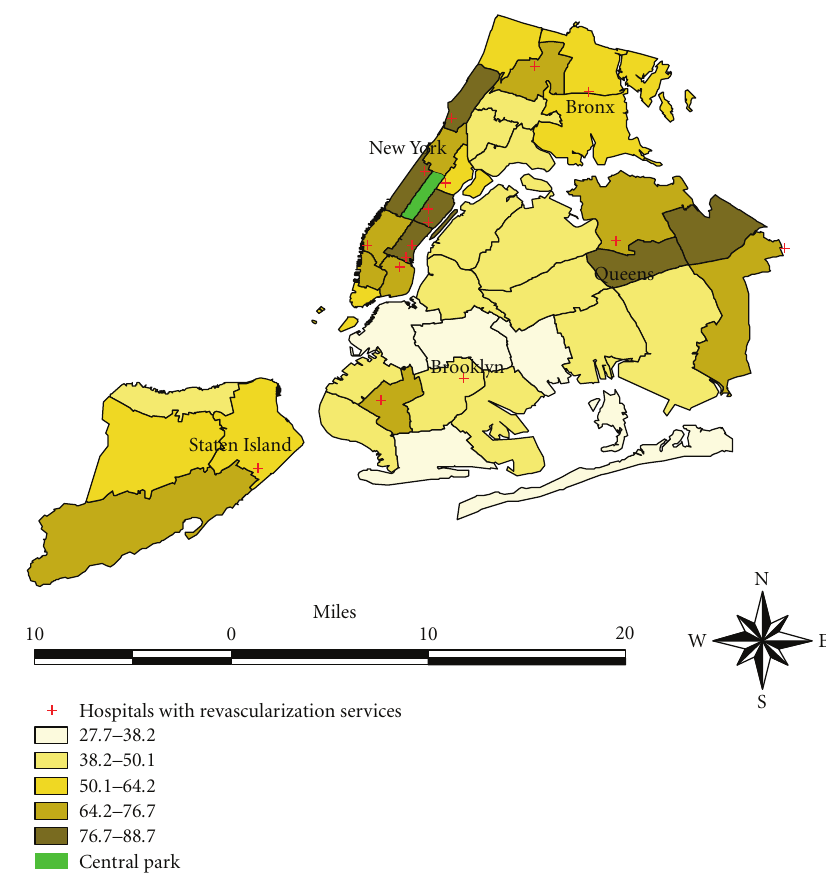
Figure 3: Pattern of access to revascularization after AMI in NYC neighborhoods